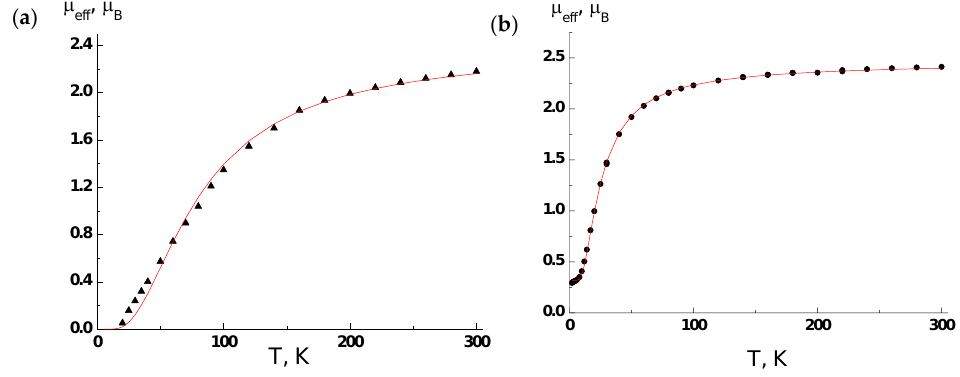
Figure 6. The μ eff ( T ) dependencies for 1 ( a ) and 2 ( b ). Solid curves are theoretical. Figure 6. The µ e ff ( T ) dependencies for 1 ( a ) and 2 ( b ). Solid curves are